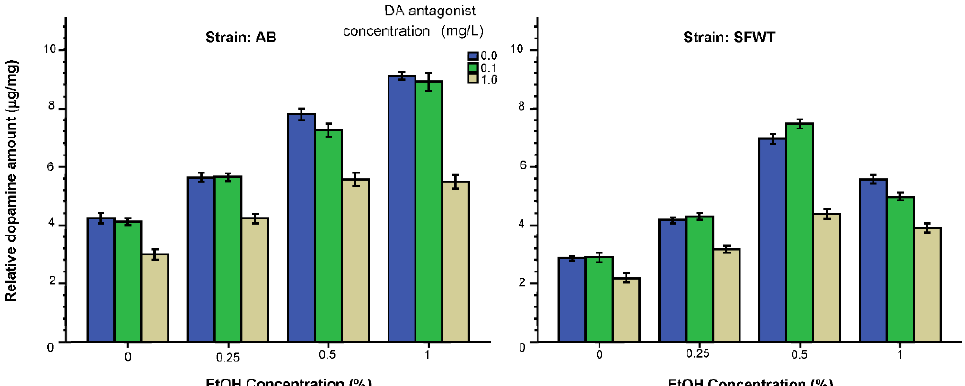
Figure 7. Dopamine levels relative to total brain protein weight are influenced by the concentration of acute alcohol (X-axis) and the concentration of acute D1-R antagonist (legend) in an interactive manner. Mean ± S.E.M. are shown. Additionally, note the significant strain difference.